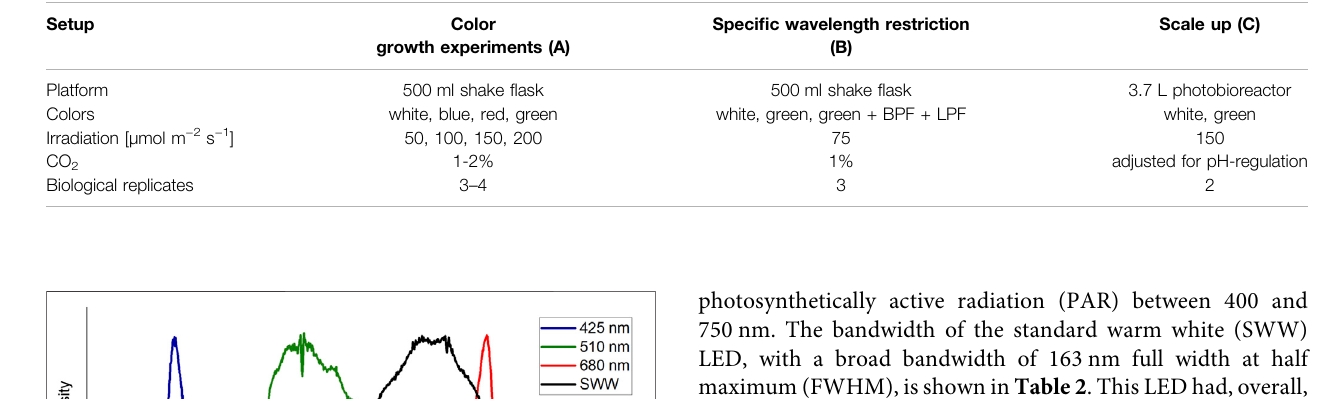
TABLE 1 | Overview of the experimental setup for the cultivation under different illumination conditions.